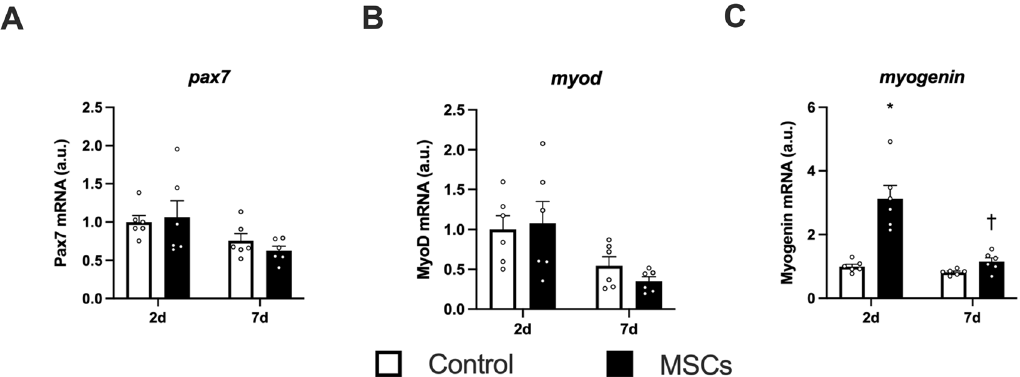
Figure 2. mRNA expression of muscle satellite cell-related markers. Expression of genes encoding Pax7 ( A ), MyoD ( B ), and Myogenin ( C ). Data are expressed relative to the control leg at 2 days post intramuscular injection of MSCs as the mean ± SE. A significant main effect of time was observed in MyoD (P < 0.05). * P < 0.05 vs Control and † P < 0.05 vs ipsilateral muscle at 2 days